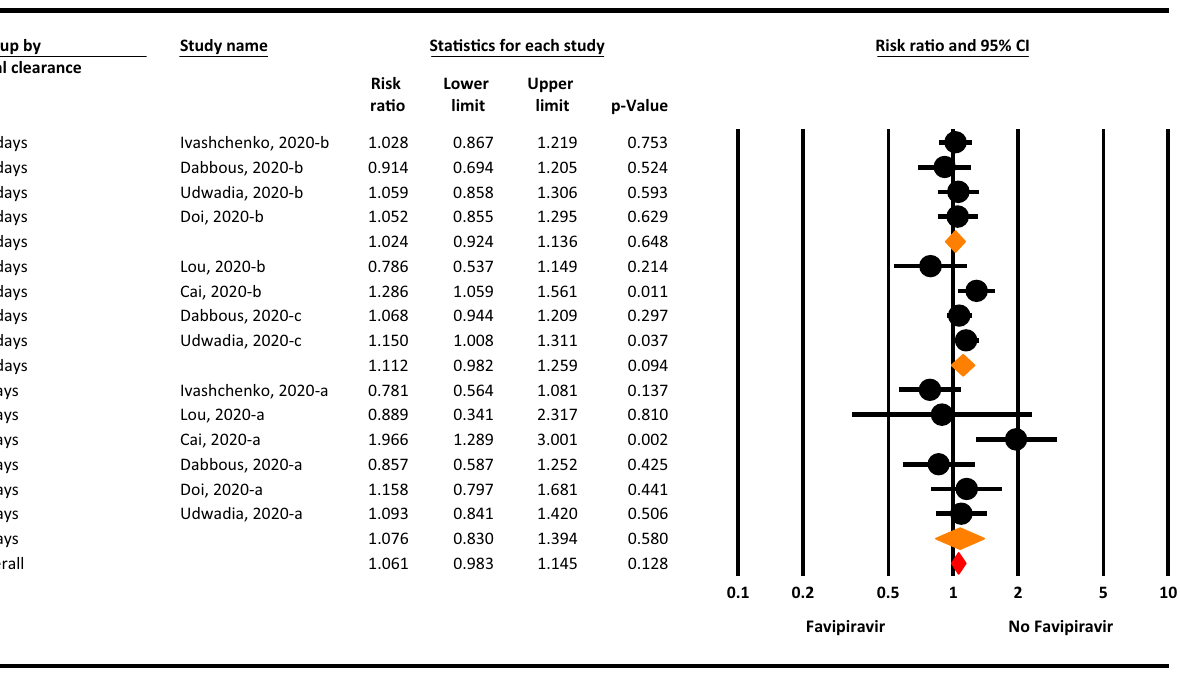
Figure 3. The meta-analysis of viral clearance of Favipiravir on COVID-19 patients (orange diamond: summery of sub groups; red diamond: summery of